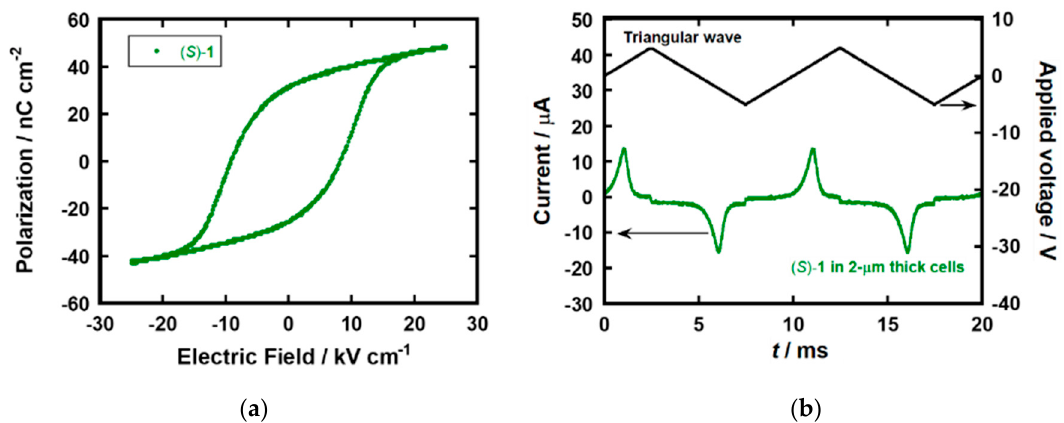
Figure 2. ( a ) Ferroelectric hysteresis loop and ( b ) polarization inversion current in the SmC* phases of compounds ( S ) − 1 at 100 ◦ C in 2 µ m thick cells.